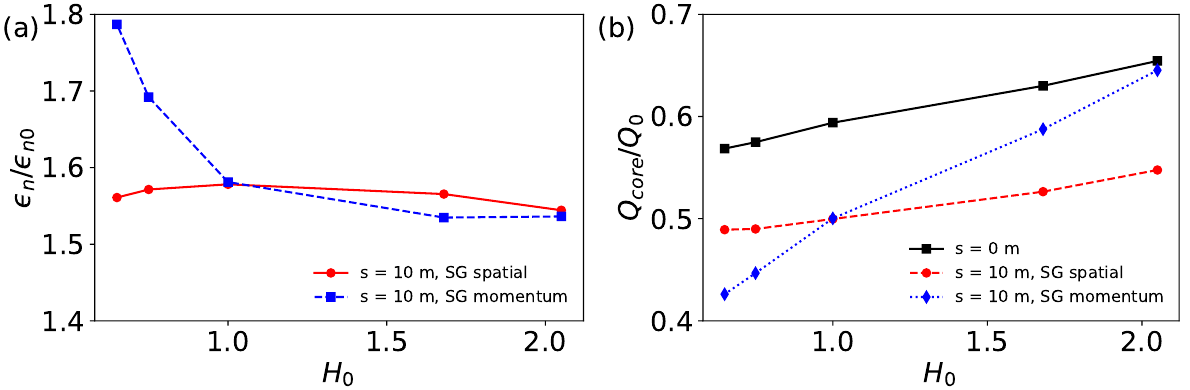
Figure 8. Comparison of the influences of initial SG spatial profiles and the SG momentum profile. Results of the low-charge (120 pC) witness beams are shown. ( a ) The normalized transverse emittance (cid:101) n . ( b ) The charge-in-core ratio Q core / Q 0 .